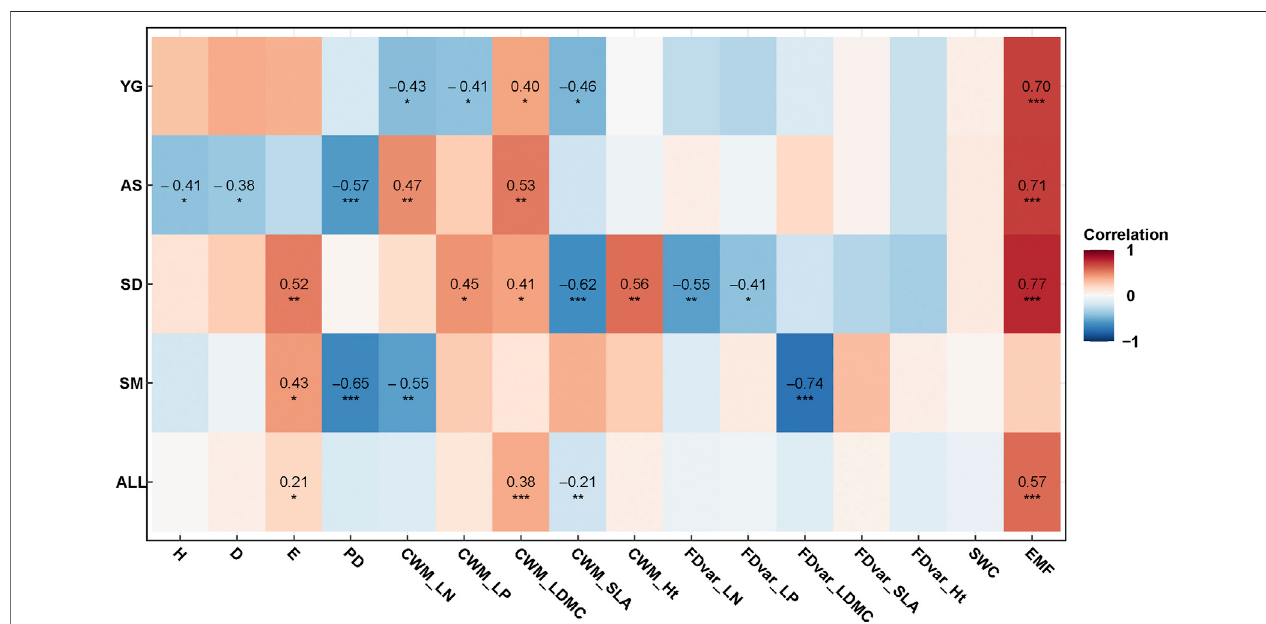
FIGURE2 | Pearson ’ scorrelations ofdiversity indices, SWC and EMF with stand age at differentsites and all sites together. H, Shannon-Wiener diversity index; D, Simpson ’ s dominance index; E, Pielou evenness index; PD, phylogenetic diversity; SLA, speci fi c leaf area; LDMC, leaf dry matter content; LN, leaf nitrogen content; LP, leaf phosphorus content; Ht, plant height; SWC, soil water content; EMF, ecosystem multifunctionality. *, **and *** represent the signi fi cance levels of 0.05, 0.01 and 0.001,